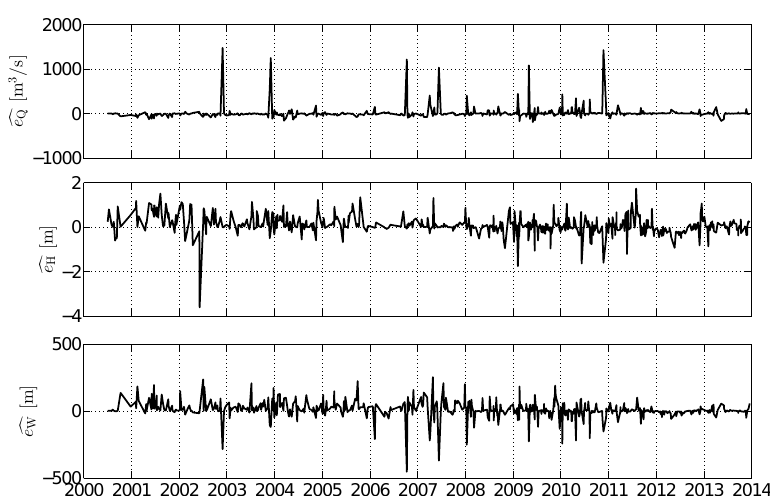
Figure 9. Estimated residual for observations of discharge ˆ e Q , water level ˆ e H and effective river width ˆ e W for the first reach along the Po